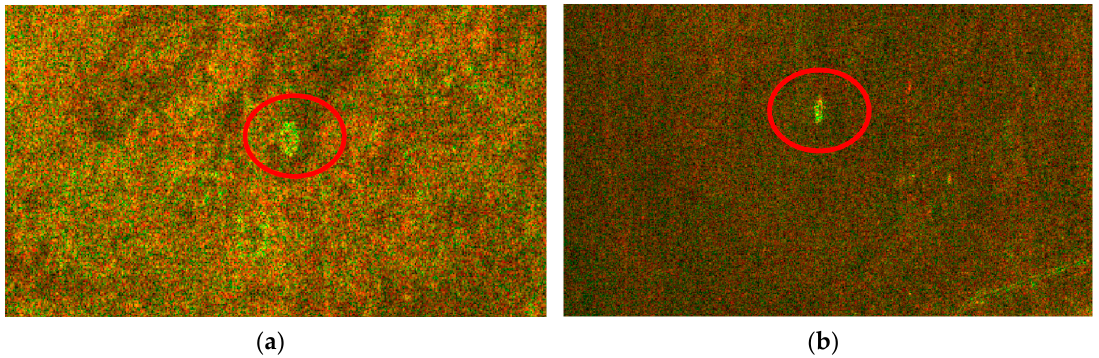
Figure 4. PALSAR-2 slant-range image of ( a ) Tunnug 1 and ( b ) Arzhan 5. Red: HH; green: HV; blue: 0 . © JAXA.